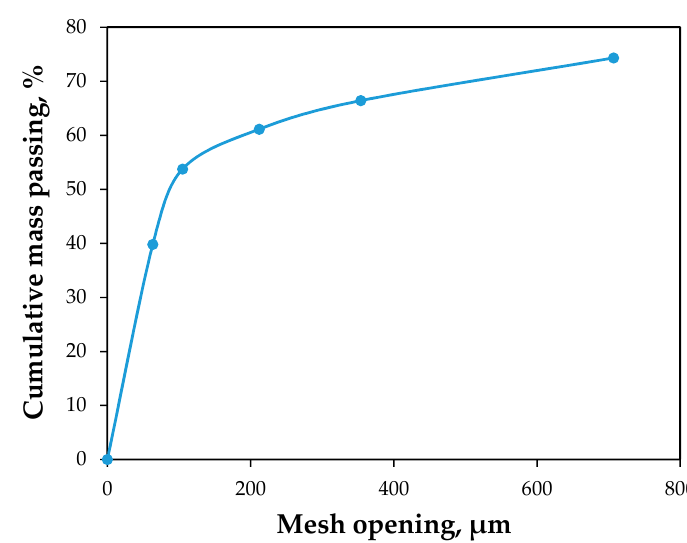
Figure 4. Particle size distribution of ore tailing.